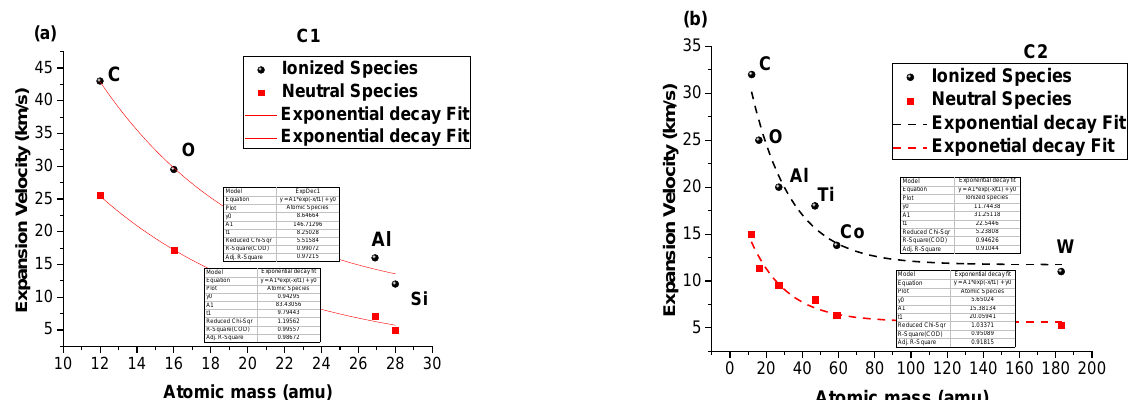
Figure 6. Individual expansion velocity evolution with the atomic mass for C1 ( a ) and C2 plasma ( b ).